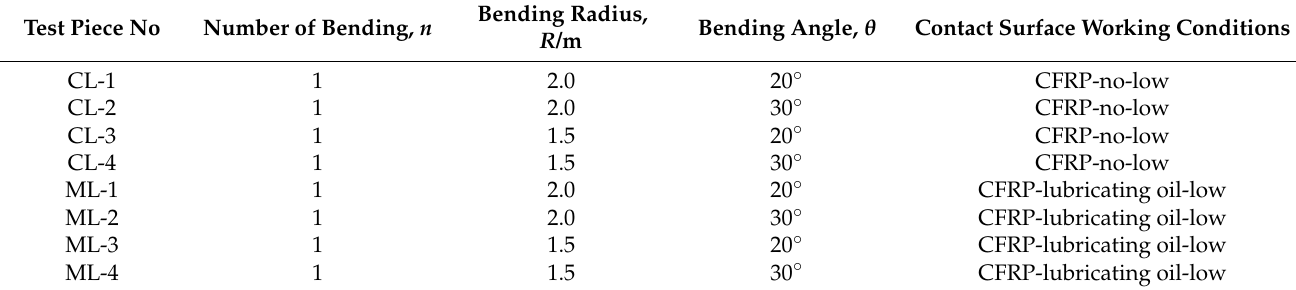
Figure 4. The uT7150A static strain gauge. Table 2. The test conditions of the prestressed CFRP